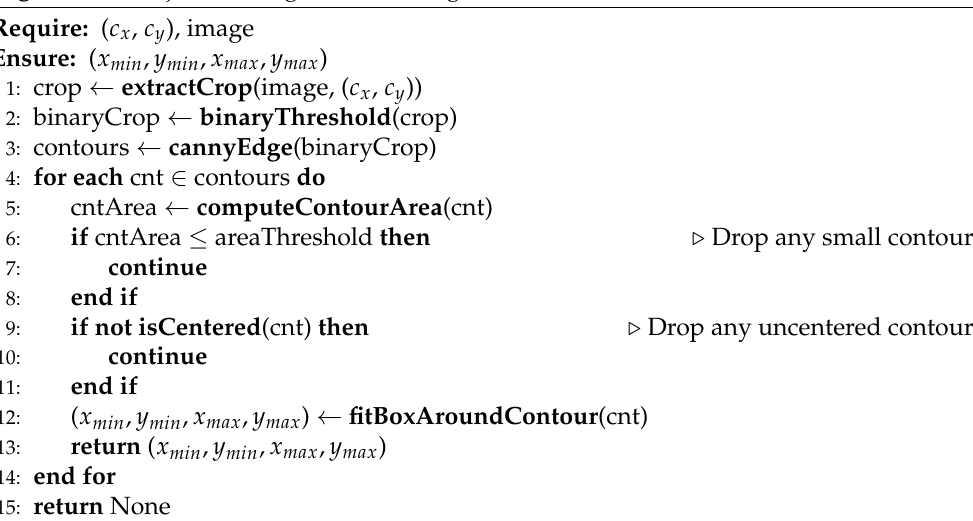
Algorithm 1 Object filtering and bounding box